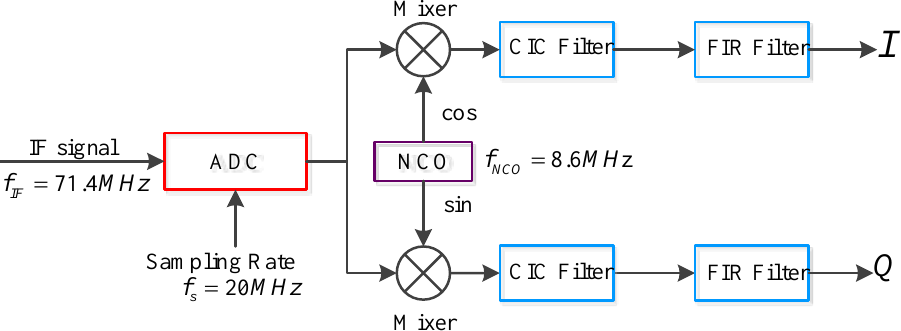
Figure 7. The structure of the DDC module. Digital mixing and filtering are implemented in FPGA, which generate the baseband signals and reduce the data rate.